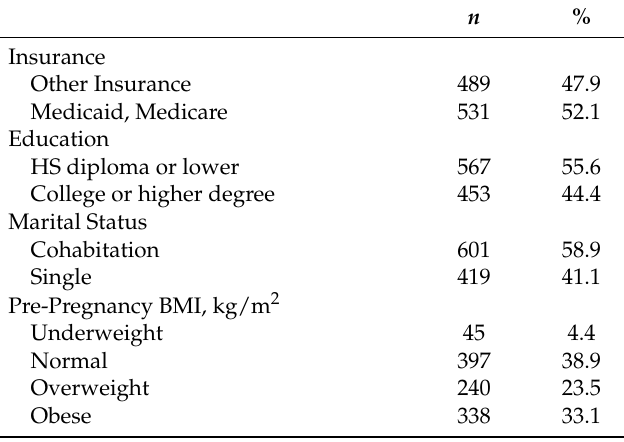
Table 1. Characteristics of the Mothers at Enrollment and the Children at 2-year Assessment (CV2; n =